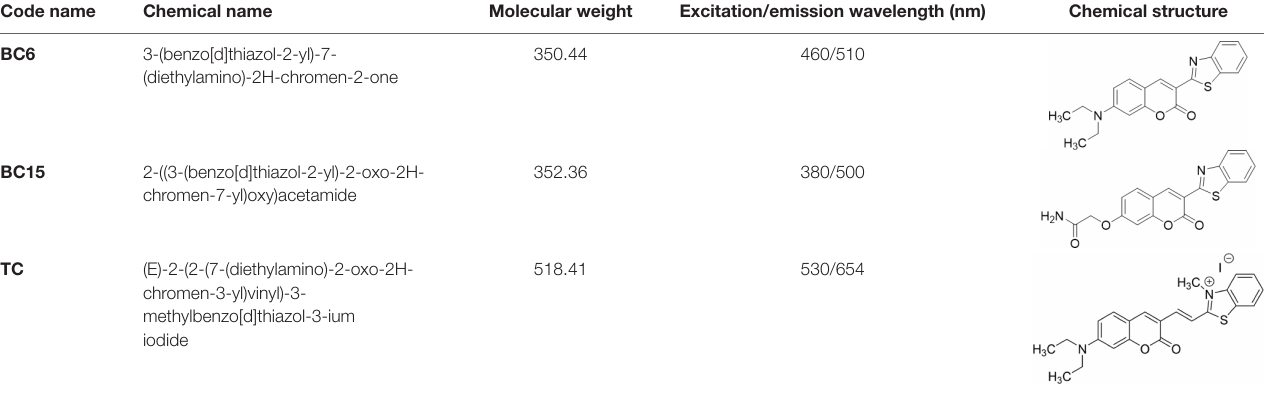
TABLE 1 | Chemical identity of the A β probes.